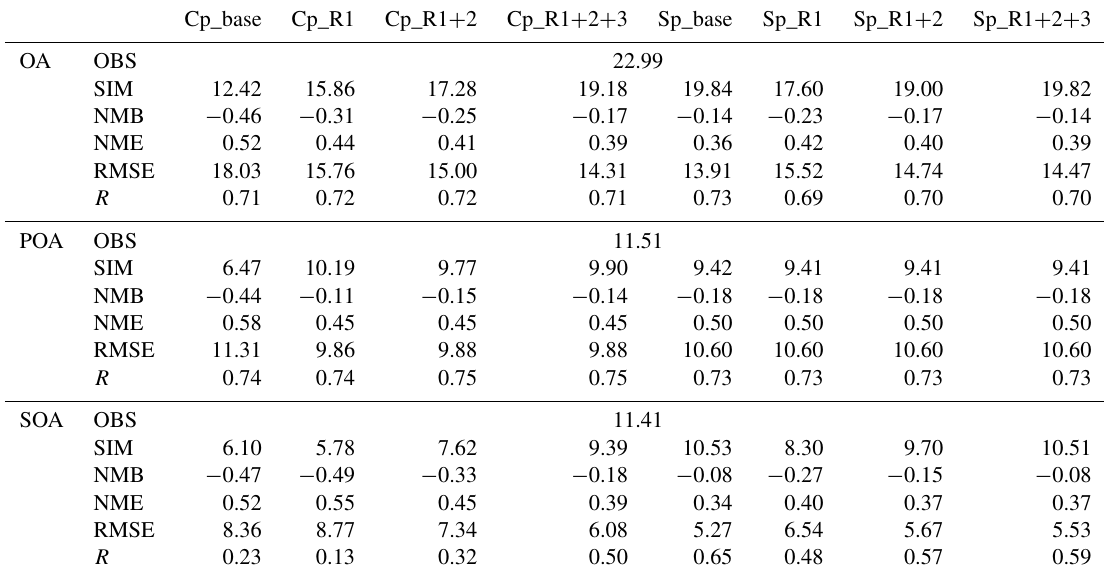
Table 3. The statistics of model–observation comparisons of the campaign-average mass concentrations of OA, POA, and SOA in China. “OBS” and “SIM” represent the mean values of the observations and the simulations, respectively. NMB is normalized mean bias, NME is normalized mean error, RMSE is root mean square error, and R is Pearson’s correlation coefficient. The units of OBS, SIM, and RMSE are µgm − 3